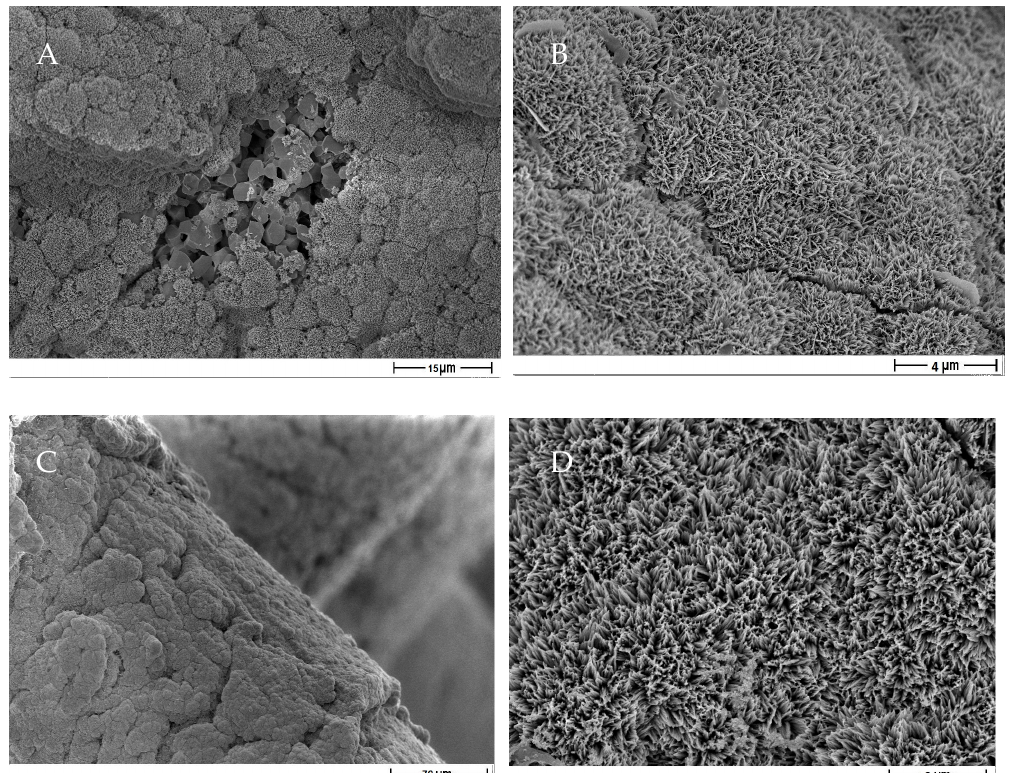
Figure 13. The new precipitated CaP layer on the surface of the bi-layer robocast structures. Low magnification images show the partial ( A ) and entire ( C ) coverage on the surface of dense and porous parts, respectively, and high magnification images show the evenly distributed rod-shaped crystals on the surface of the dense ( B ) and porous ( D ) parts. Table 4. Chemical composition of the precipitated bioactivity layer,